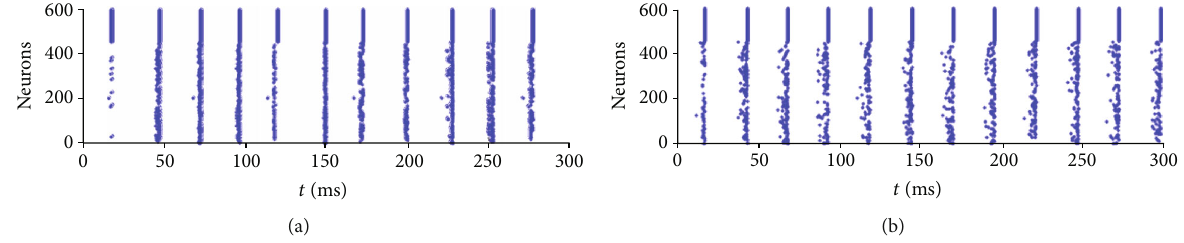
Figure 2: High-frequency oscillation in E/I networks with (a) no noisy input to the excitatory neurons, σ S excitatory neurons, σ S = 0 : 5 N